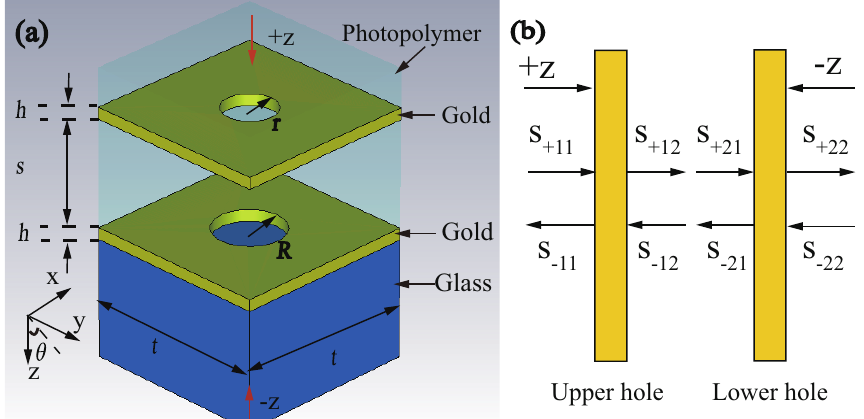
Figure 1. (Color online) ( a ) Schematic diagram of unit cell of the stacked metamaterial structure. The geometric parameters of the structure are h = 30 nm, r = 86 nm, R = 112 nm, t = 600 nm. Incident angle θ and distance s are variable, respectively. ( b ) Simple schematic diagram of scattering property of the structure. Here, the incident wave is in x–z plane and has a incident angle θ with +z axis, and the electric field is along y